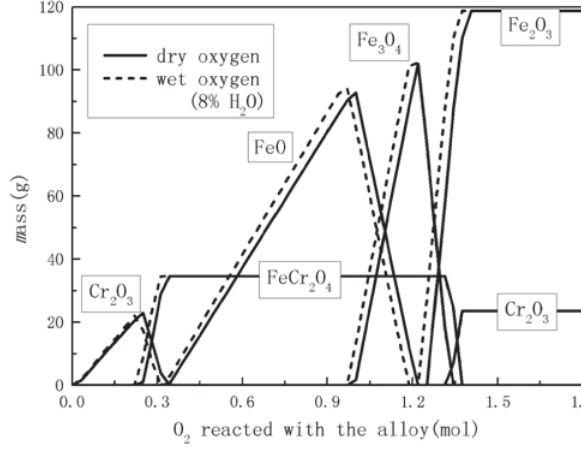
Fig. 3: Equilibrium of oxygen to Fe-Cr alloys with different Cr contents at 800 °C.